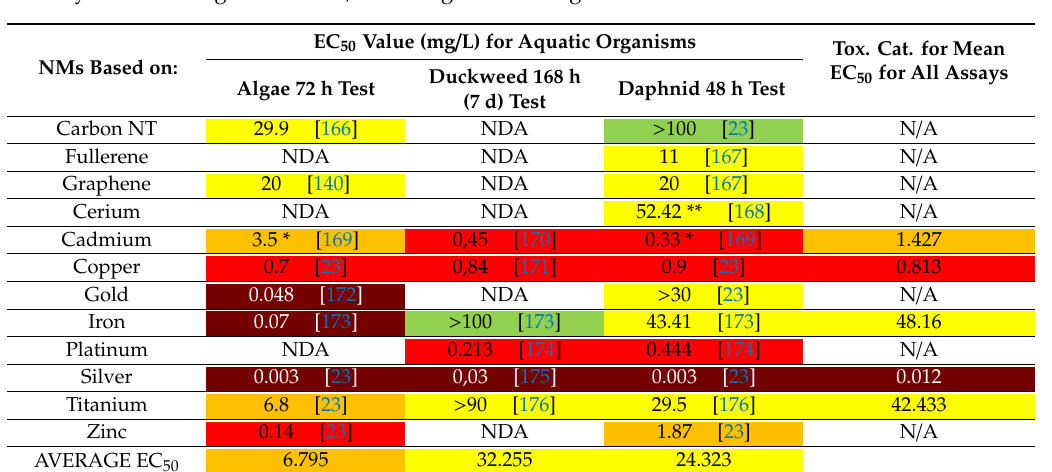
Table 6. Comparison of EC 50 values for some NMs and classification in aquatic toxicity categories. The classification into toxicity categories is color-coded as follows: values that are in the VHT / A1.1 category have dark red shading, in HT / A1.2 have red shading, in MT / A2 have orange shading, in ST / A3 have yellow shading and in PNT / A4 have green shading.